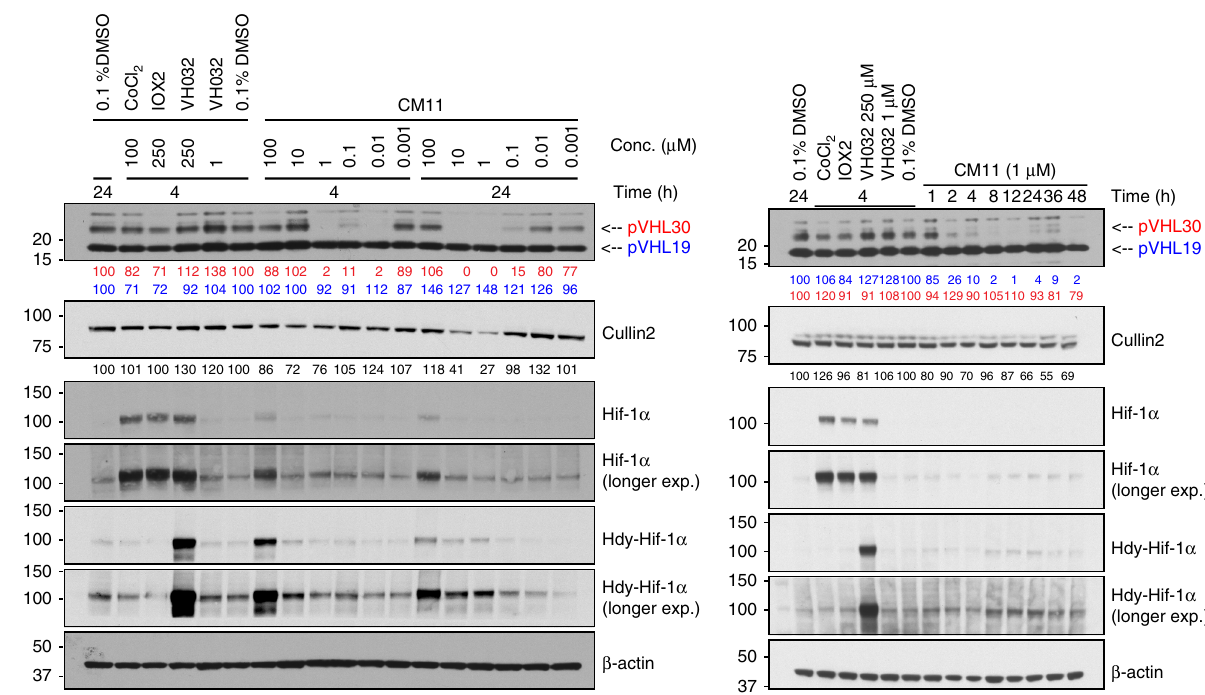
Fig. 5 CM11 induces pVHL30 depletion in a concentration and time-dependent fashion. (left) Dose-response pro fi le of HeLa cells treated with increasing concentration of CM11 for 4 or 24 h. (right) Time-course immunoblots of lysates from HeLa cells treated 1 µ M of CM11 up to 48 h. Control treatments of 0.1% DMSO, CoCl 2 (100 µ M), IOX2 (150 µ M), and VH032 (250 µ M or 1 µ M) are included. All data demonstrated is a representative example of experiments performed in biological duplicates